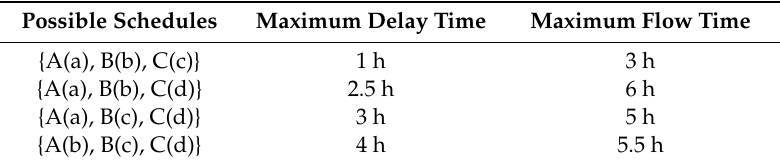
Table 3. Example results obtained from the first step of the proposed scheduling algorithm.